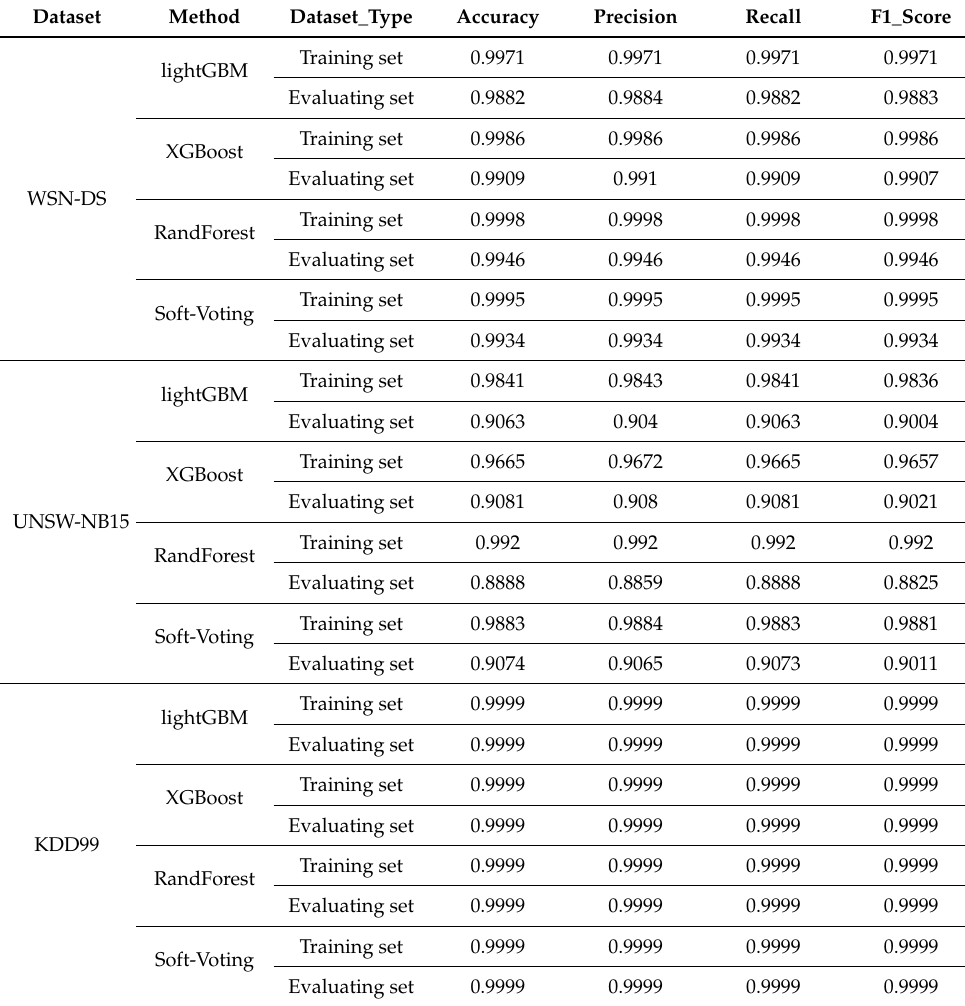
Table 12. Ensemble model on training set and evaluating